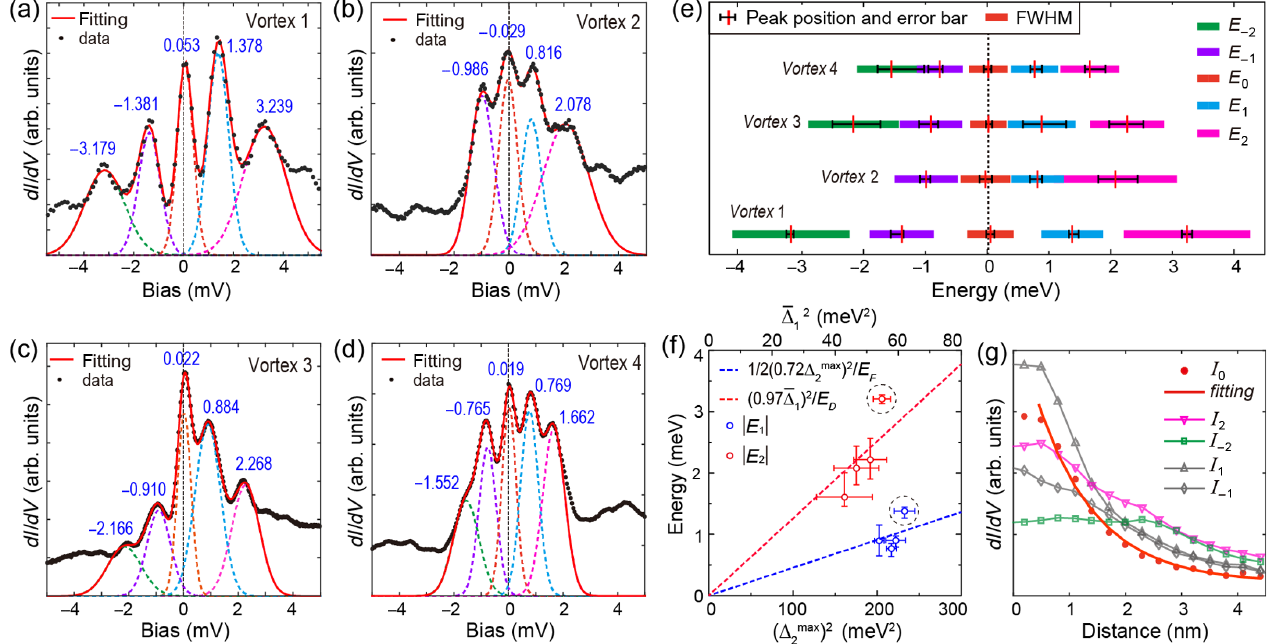
FIG. 4. Quantitative characterization of the vortex core states. (a) – (d) Summed low-energy dI=dV spectra taken near the centers of vortices 1 – 4. Black dots are experimental data. Red solid curves are the fits to multiple Gaussian peaks (dashed curves are the individual peaks). (e) Peak energy position (marked by red vertical rods) and FWHM (represented by the length of colored bars) of the core states of vortices 1 – 4, obtained from Gaussian peak fitting. The black error bars represent the ranges of peak energy fluctuations (see Sec. S8 of Ref. [30] for more details). (f) Plots of j E 2 j (red circles) as a function of ð Δ 1 Þ 2 and j E 1 j (blue circles) as a function of ð Δ max 2 Þ 2 . Dashed lines are the linear fitting (see legend). (g) Spatial dependence of the intensity of the core states. Here, I 2 , I 1 , I 0 , I − 1 , and I − 2 represent the intensity ( dI=dV values at the peak energy) of the five core states E 2 , E 1 , E 0 , E − 1 , and E − 2 of vortex 1. The red solid curve is the exponential fit to the decay of E 0